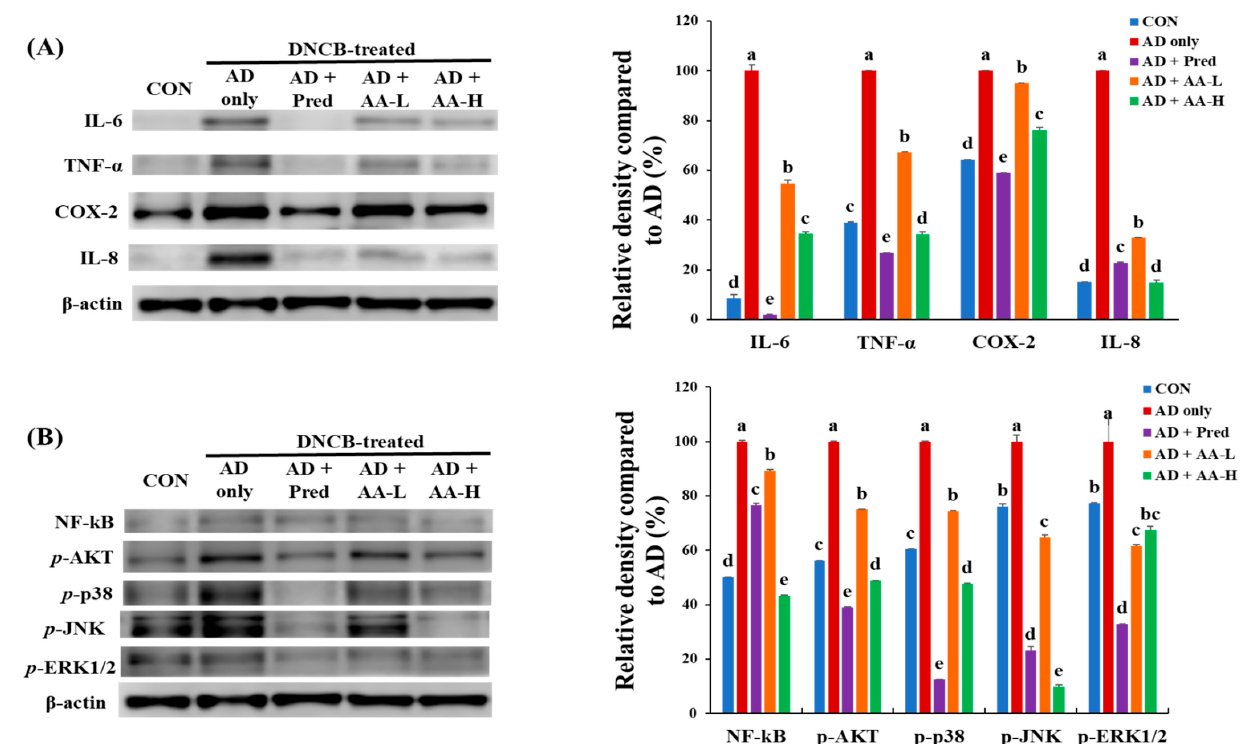
Figure 7. Effects of asiatic acid (AA) on the expression of inflammatory and signaling proteins in the dorsal skin. Expression of ( A ) anti-inflammatory pathway proteins and ( B ) nuclear factor kappa B (NF- κ B), phosphor( p )-protein kinase B (Akt), p -p38, p -c-Jun N-terminal kinase (JNK), and p -Extracellular-Regulated Protein Kinase 1/2 (ERK1/2) proteins. Different letters indicate significant values per Duncan’s multiple range test ( p < 0.05), and values are expressed as mean ± standard deviation (n = 7 per group). CON, control group; AD only, mice sensitized with 0.25% 2,4-dinitrochlorobenzene (DNCB) in 200 µL of 3:1 acetone/bean oil; AD + AA-L and AD + AA-H, 30 and 75 mg/kg AA-treated DNCB-sensitized mice, respectively, in 100 µL of sterilized drinking water; AD + Pred, positive control mice treated with 5 mg/kg prednisolone in 100 µL of sterilized drinking water.